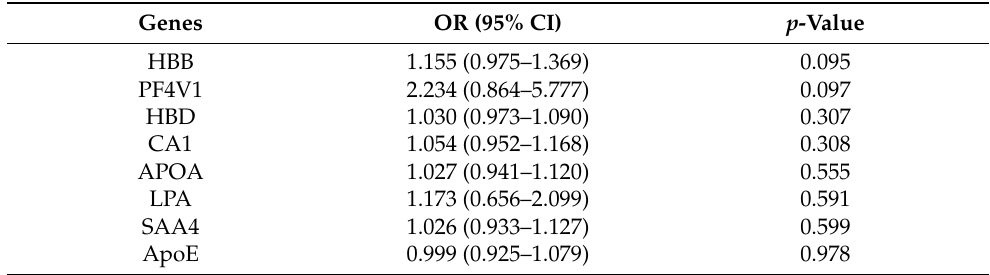
Note: OR = odds ratio; CI = confidence